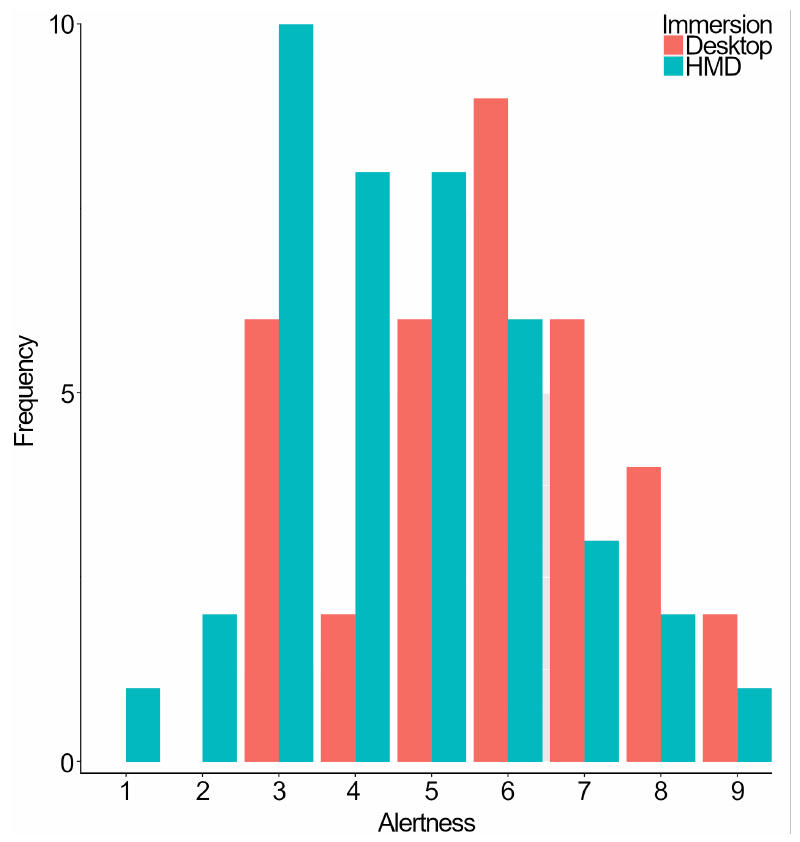
Figure 7. Total count of alertness responses in the KSS